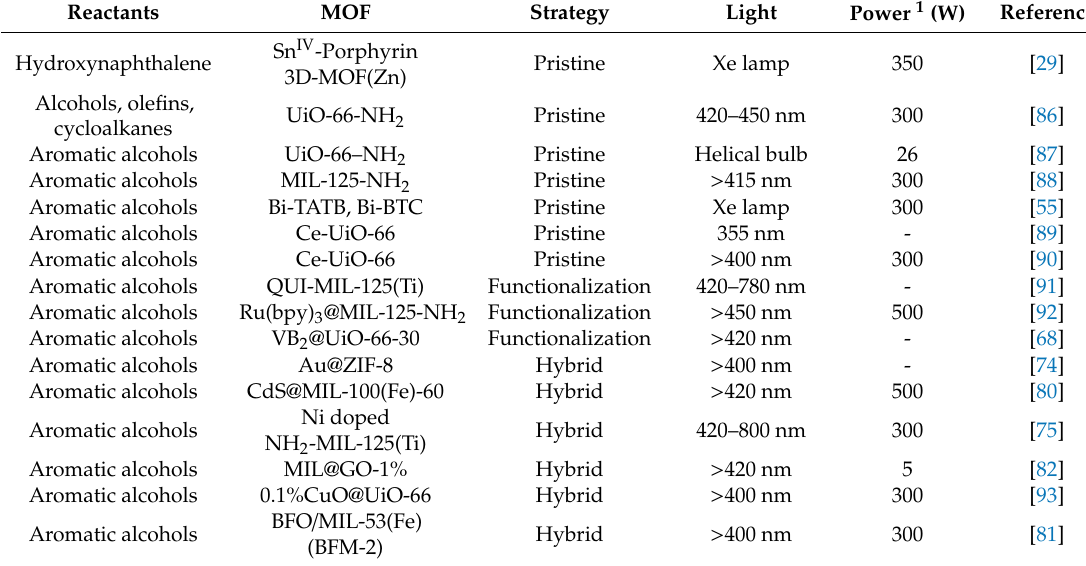
Table 1. Photooxidation reactions of alcohols mediated by